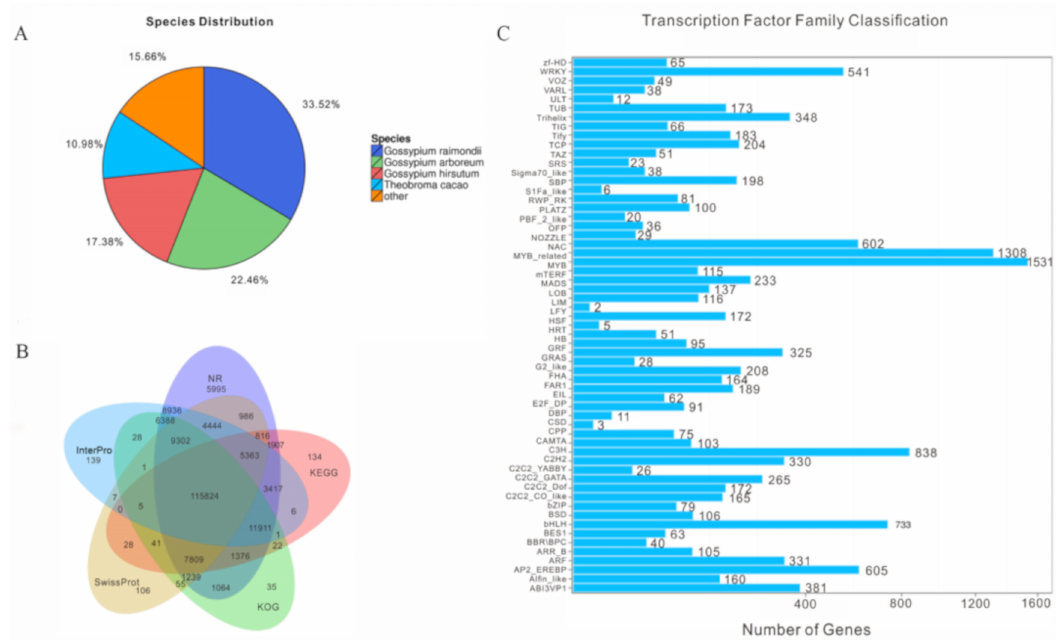
Figure 2. Functional annotation of kenaf unigenes. ( A ) The distribution of non-redundant (NR) annotated species is shown as a percentage of the total homologous sequence. ( B ) Venn diagram comprising the results of the NR, EuKaryotic Orthologous Groups (KOG), Kyoto Encyclopedia of Genes and Genomes (KEGG), Swiss-Prot, and InterPro database information. ( C ) Transcription factor (TF) family classification of unigenes. The X axis represents the number of unigenes. The Y axis represents the TF